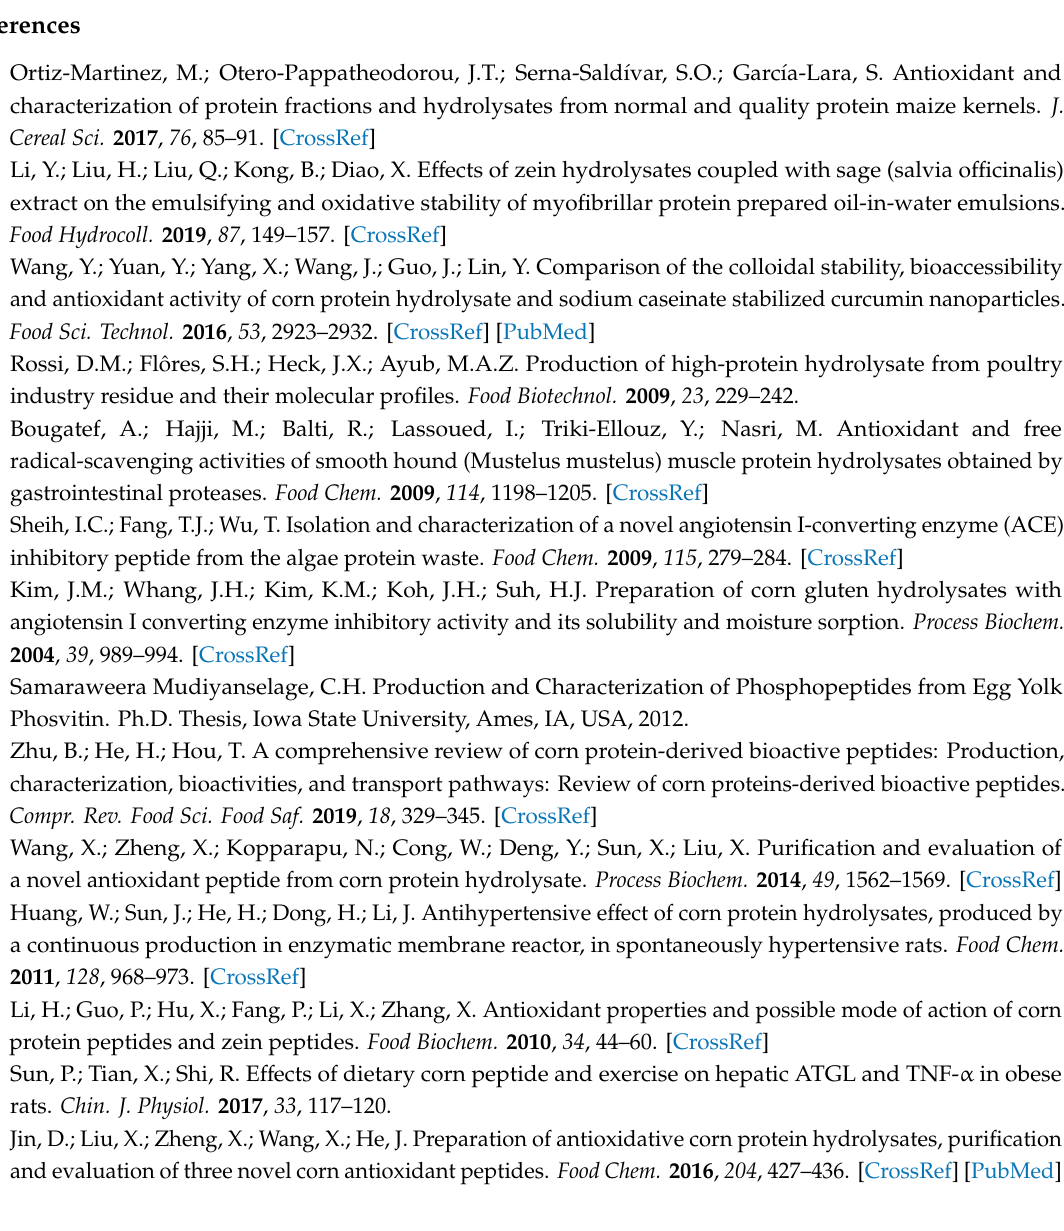
Supplementary Materials: The following are available online, Table S1: Peptide sequences of 3–5 kDa peptide fraction ultrafiltrated from bromelain-hydrolyzed CGM with 4 h hydrolysis; Table S2: Peptide sequences of < 1 kDa peptide fraction ultrafiltrated from ficin-hydrolyzed CGM with 4 h hydrolysis; Table S3. Peptide sequences